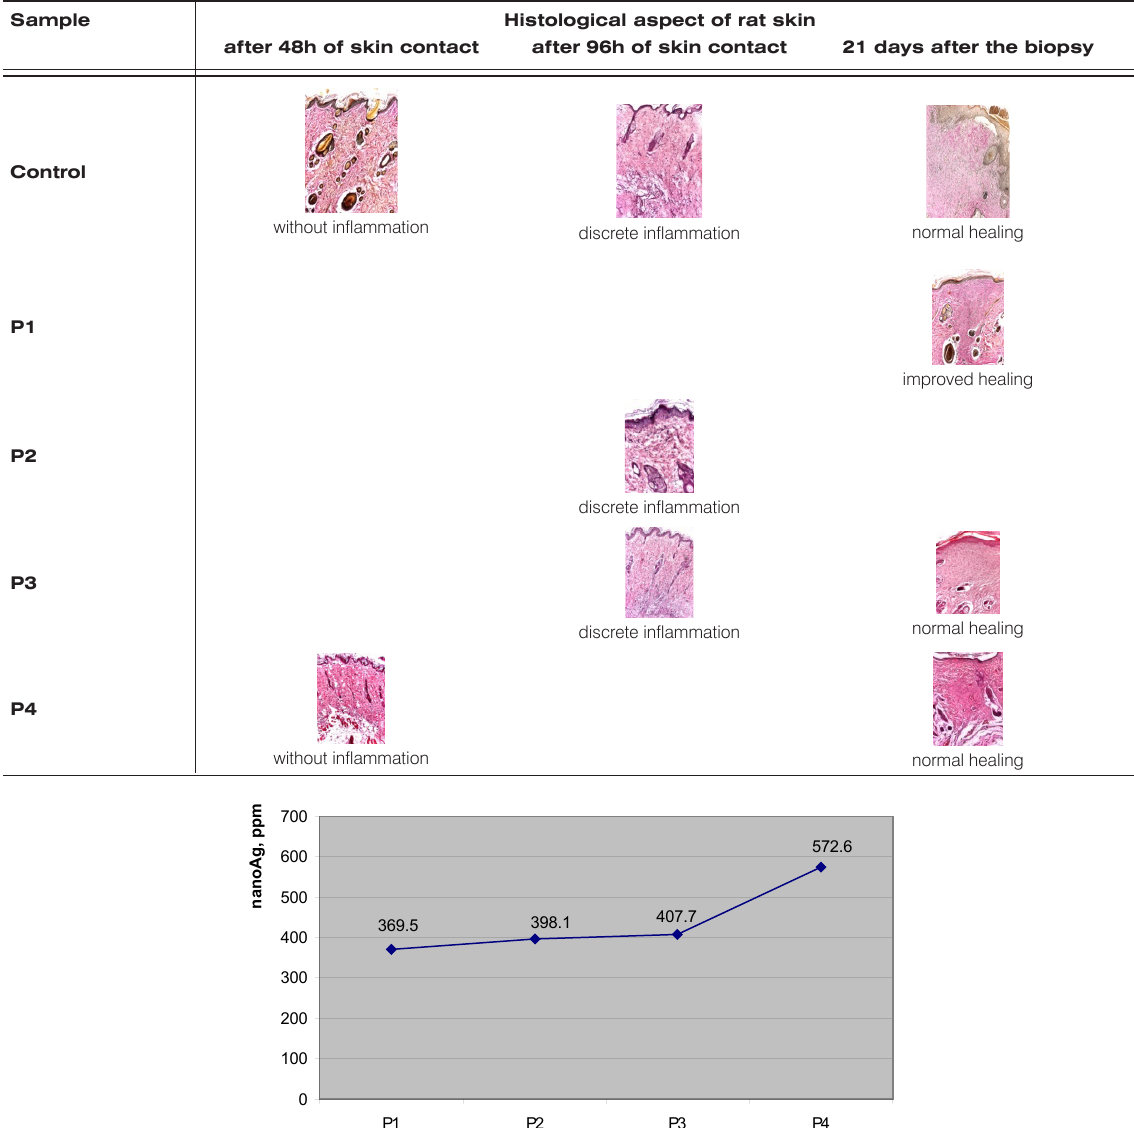
Table 6. The histopathological study of sensitisation induced by AgNPs-treated sheepskins to rat skin.